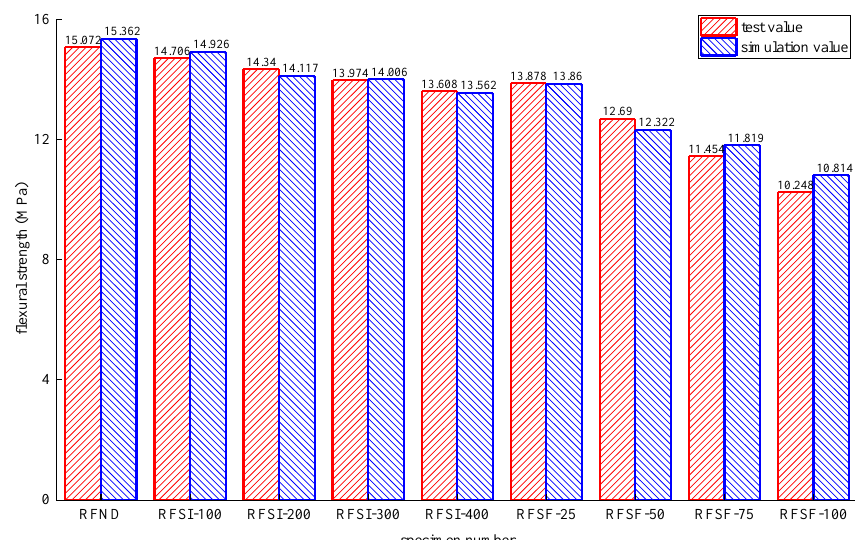
Figure 44. Test values and simulated values of flexural strength of reinforced concrete flexural specimen.